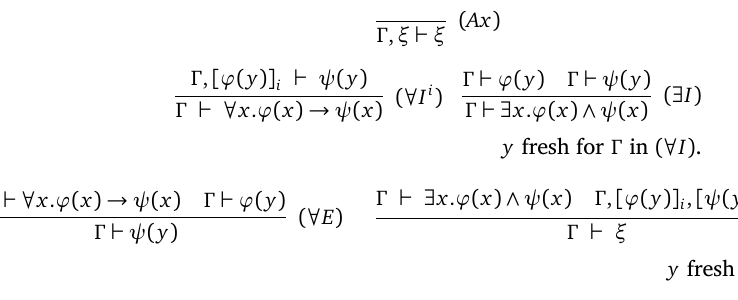
Figure 1: A natural-deduction proof system N rq for restricted